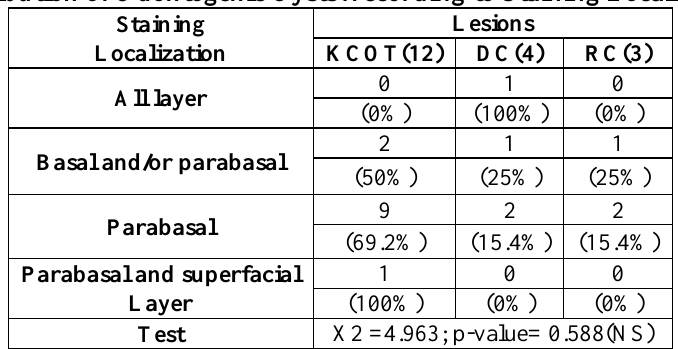
Table 5:Case Distribution of Odontogenic Cysts According to Staining Localization of Cyclin D1